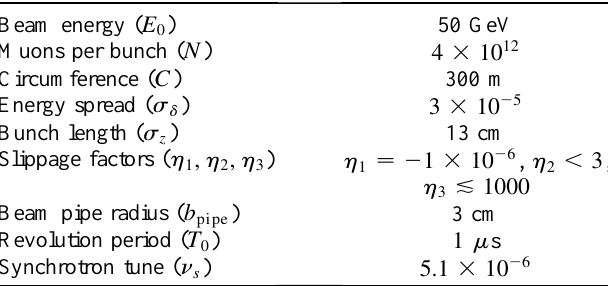
TABLE I. Parameters of the 50 GeV muon collider